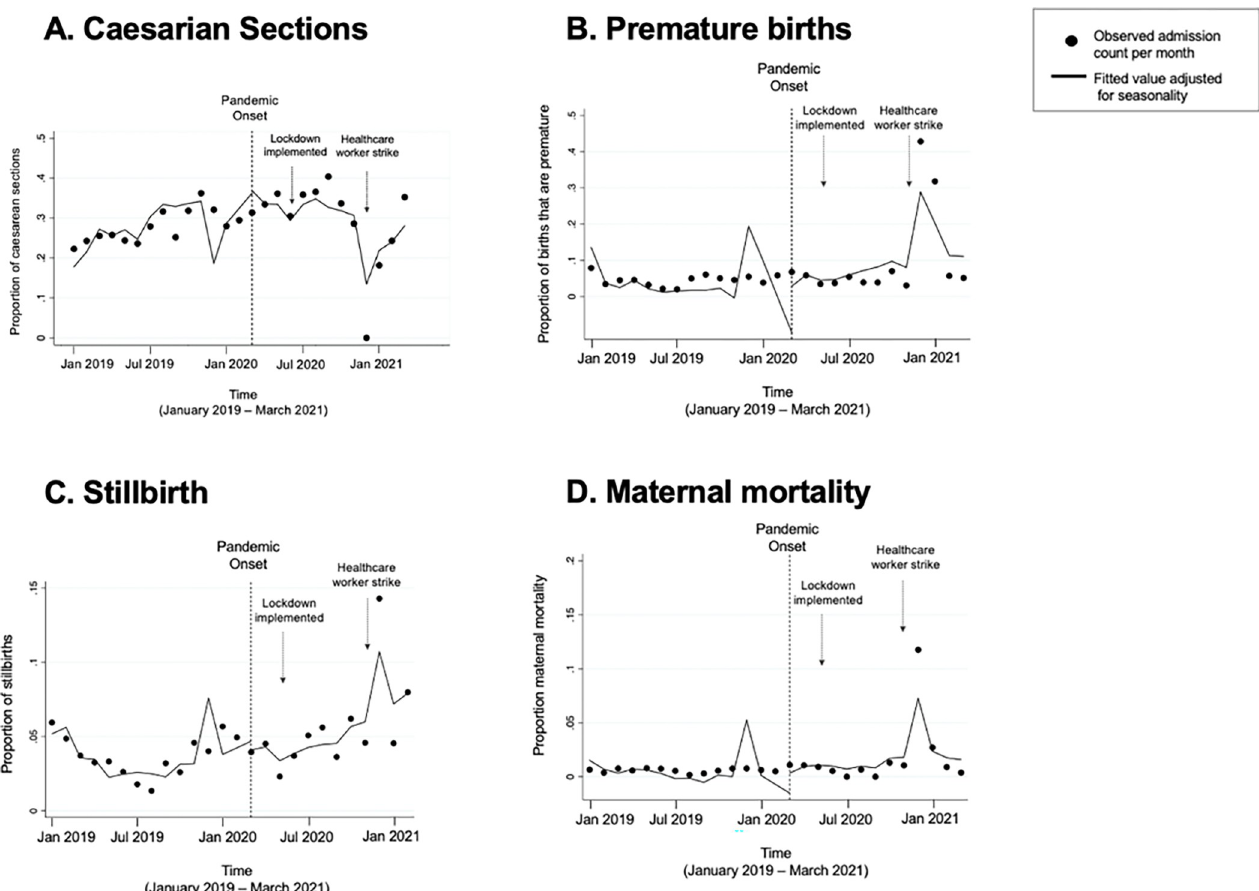
Fig 2. Proportion of total admissions resulting in caesarean sections, premature births, stillbirths, and maternal deaths comparing pre-pandemic (January 2019 –February 2020) to pandemic (March 2020 –March 2021) periods.